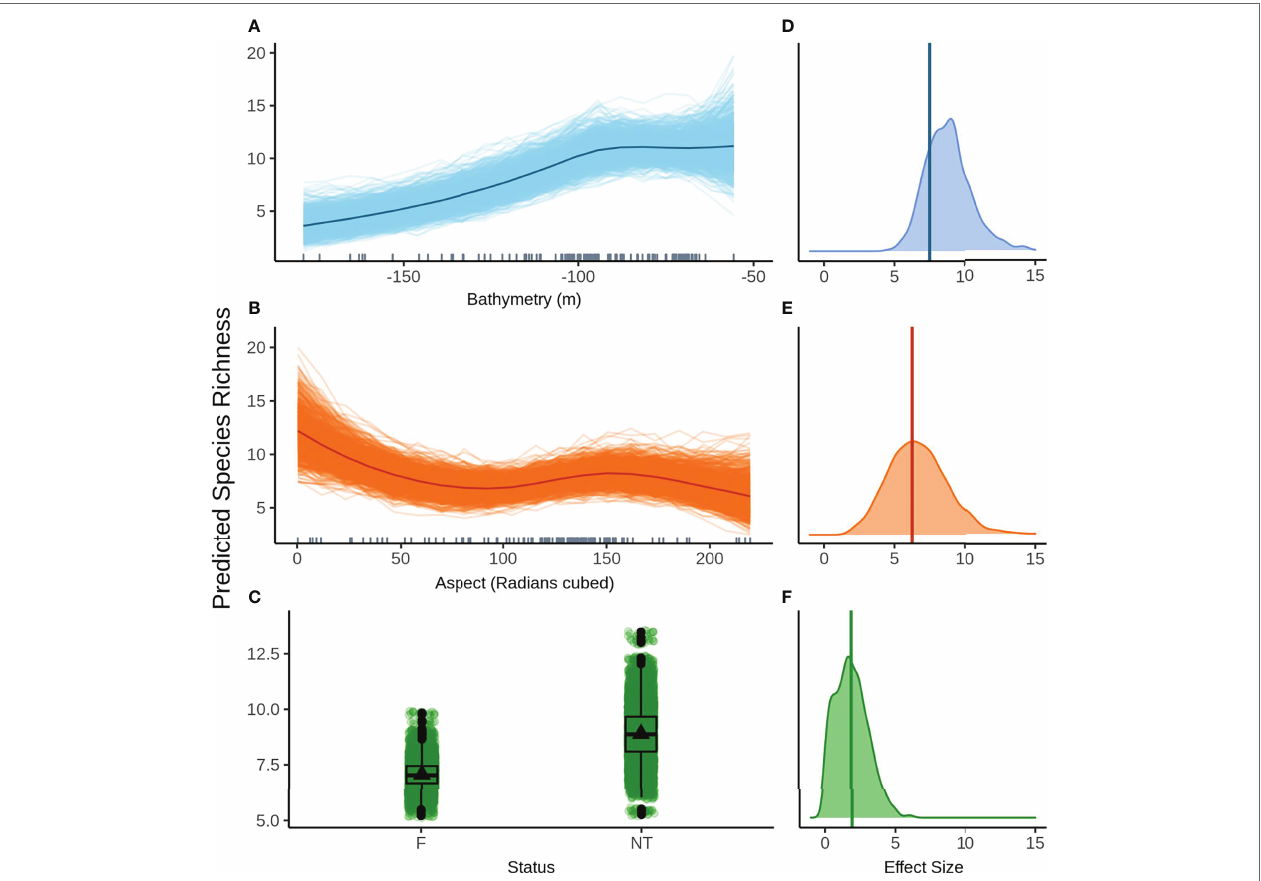
FIGURE 6 | Predicted values for the top ranked model for species richness when field of view variables were not included - (A) bathymetry (m), (B) aspect (radians cubed), (C) status (F, fished areas; NT, no take area). Density plots of effect size are also plotted for each aforementioned predictor – (D−F) respectively – with a vertical line indicating the frequentist effect size